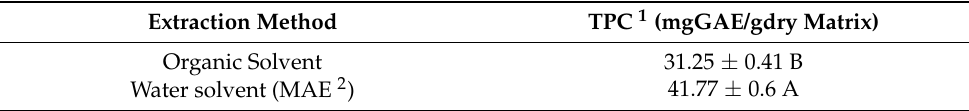
Table 5. TPC (mgGAE/gdry matrix) obtained with the optimized MAE and the conventional method (organic solvent) from blackcurrant by-products. Different letters indicate significant differences for p < 0.05 (means of three reps).